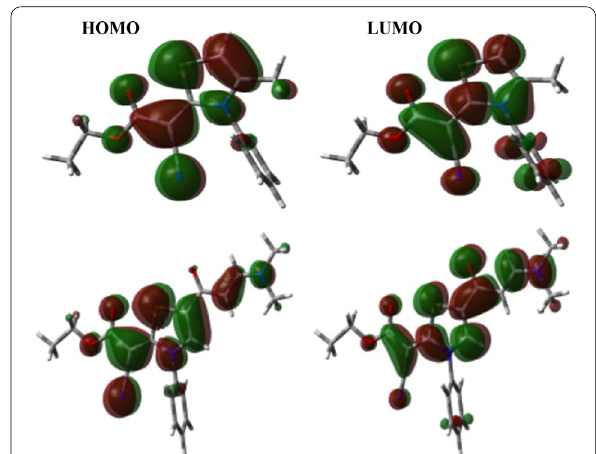
Fig. 8 The frontier molecular orbitals of the synthesized compounds 6 and 11 calculated at the B3LYP/6‑31G(d,p) level